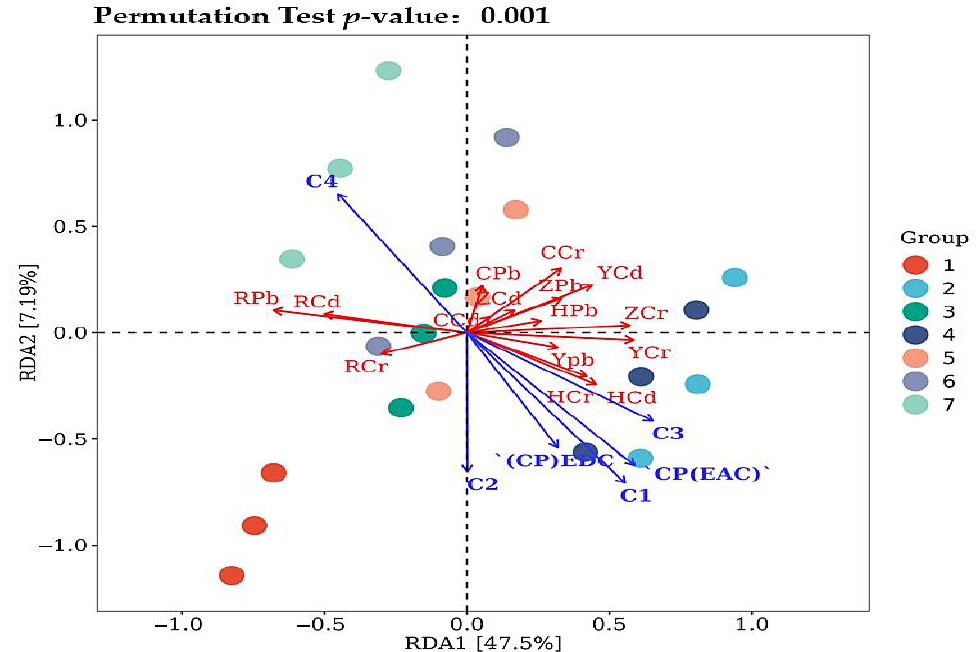
Figure 6. Redundancy analysis of soil DOM components and their ETC with total amount and forms of heavy metals (R, H, Y and C represent the weak acid extractable state, reducible state, oxidizable state and residual state of heavy metals, respectively. RDA2 represents the variance proportions that the constraint axis can